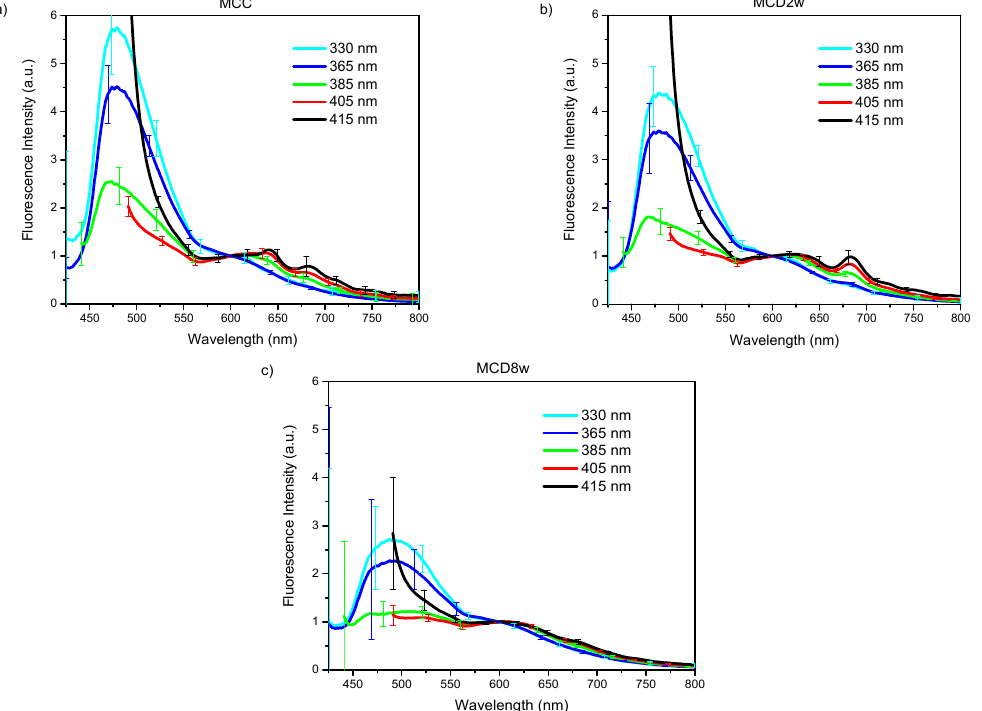
Figure 4. Group mean spectra with spectral sensitivity correction and normalization at 600 nm, used excitation lights are indicated in the legend, bars indicate the standard deviation: ( a ) MCC group; ( b ) MCD2w group; ( c ) MCD8w group.